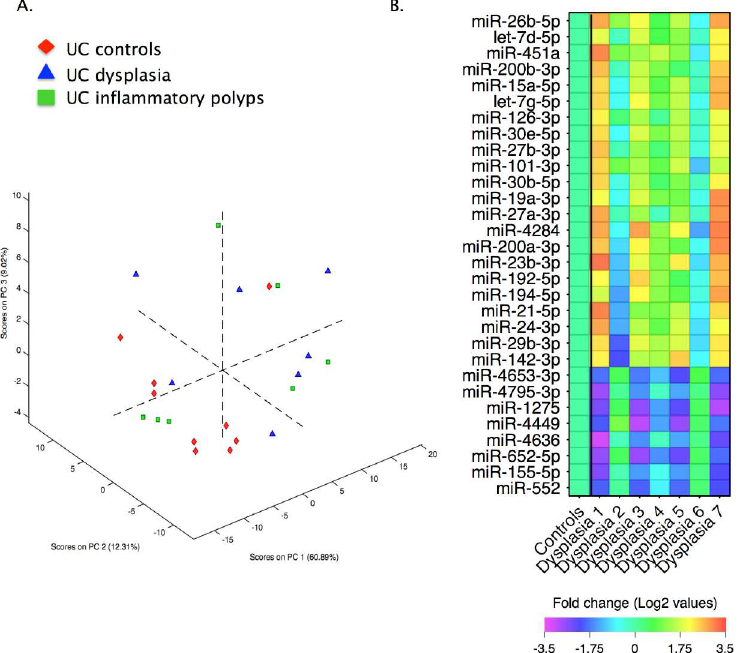
Fig 1. Altered miRNA profiles in ulcerative colitis associated-dysplasia. (A) Principalcomponent analysisof UC-controls, UC-Dysplasias and UC-inflammatory polyps, showingnatural groupingswithin the data alongthe first three principalcomponents. (B) Heatmap of miRNAs identifiedby permutationanalysisas differentially expressedin UC-dysplasia relative to UC-controls. The data are presentedas Log2 fold change in UC-dysplasia relativeto UC-controls, and the y-axis is ranked